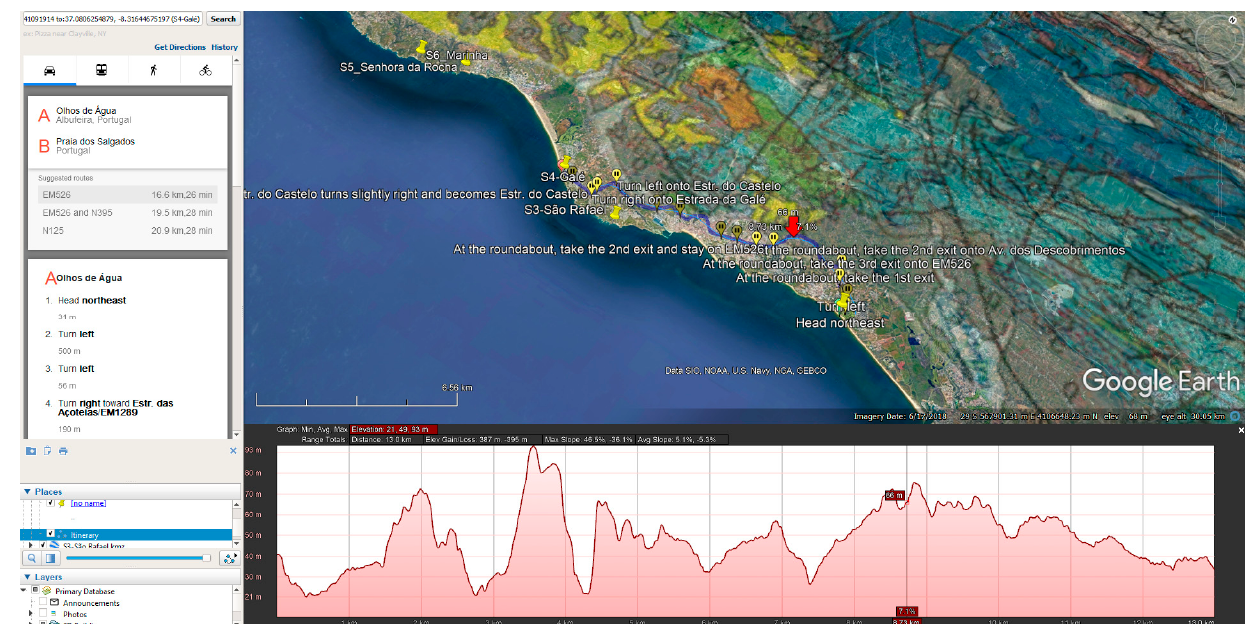
Figure 7. Capture of the geosites in the natural space of Marinha-Galé-Sao Rafael. Images of the location of some stops on geologic cartography and interpretive schemes are shown.